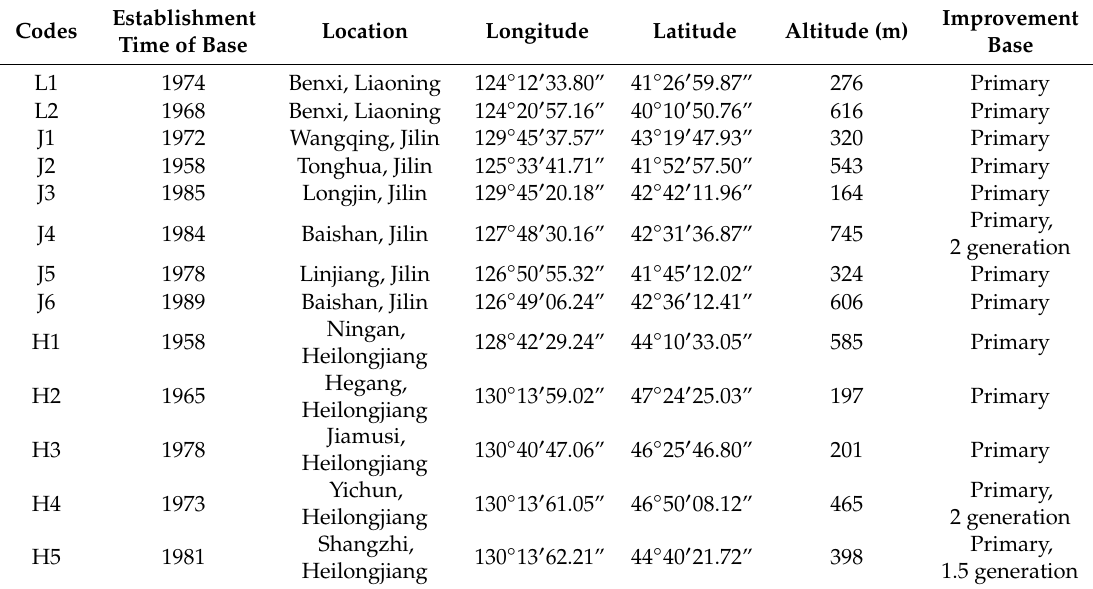
Table 2. Distribution of national-level Pinus koraiensis improved variety bases in